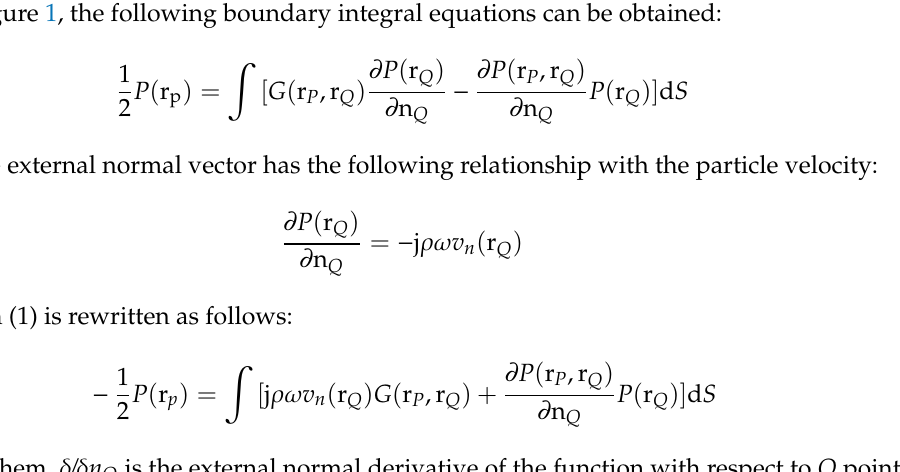
Figure 3. Two-point relationship schematic level .